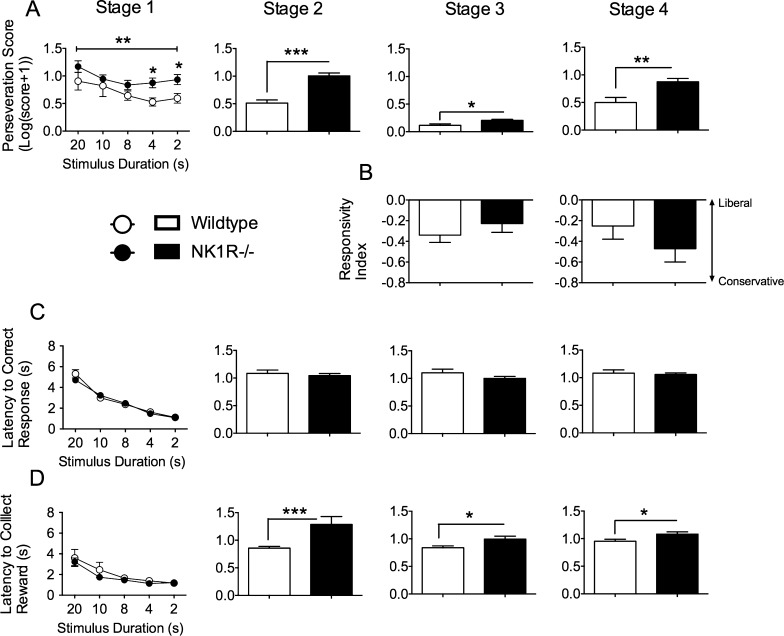
By comparison with wildtypes, NK1R−/− mice carried out more perseverative responses and had a longer latency to collect their reward during training and testing in the 5C-CPT. Circles/bars show mean ± s.e.m. A: perseveration score; B: responsivity index; C: latency to correct response; D: latency to collect reward. Numbers on abscissae for Stage 1 specify the stimulus durations (gradually reduced from 20 to 2 s as animals achieved progression criteria). A line above graphs/bar charts indicates an overall difference between NK1R−/− and wildtype mice. Statistical significance of differences between pairs of data (compared by genotype) indicated by: *P < 0.05; **P < 0.01; ***P < 0.001. N = 12 per group.